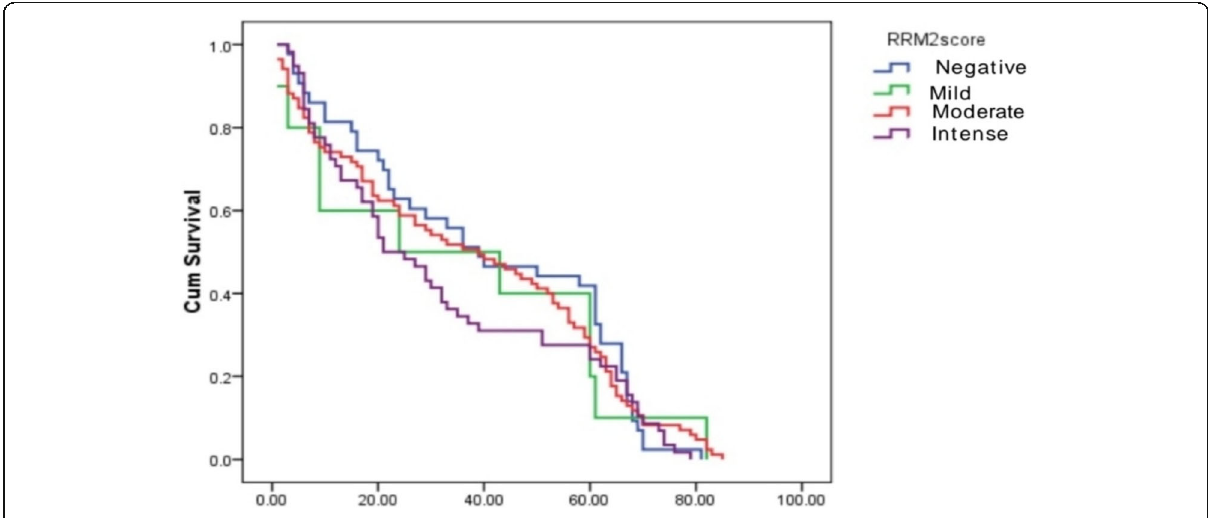
Fig. 3 A Kaplan – Meier plot of RRM2 expression and DFS in whole